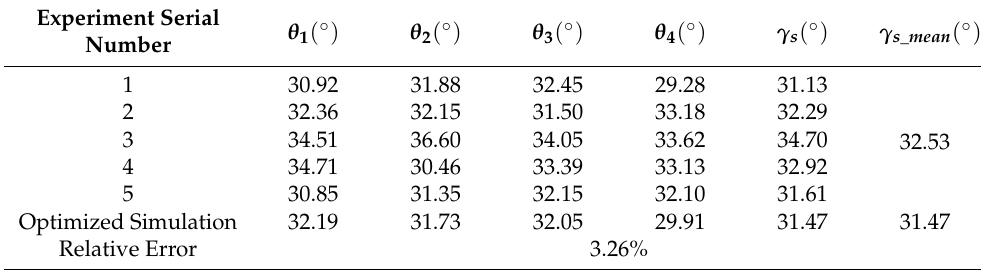
Table 10. Comparison of experimental and simulation results of static stacking